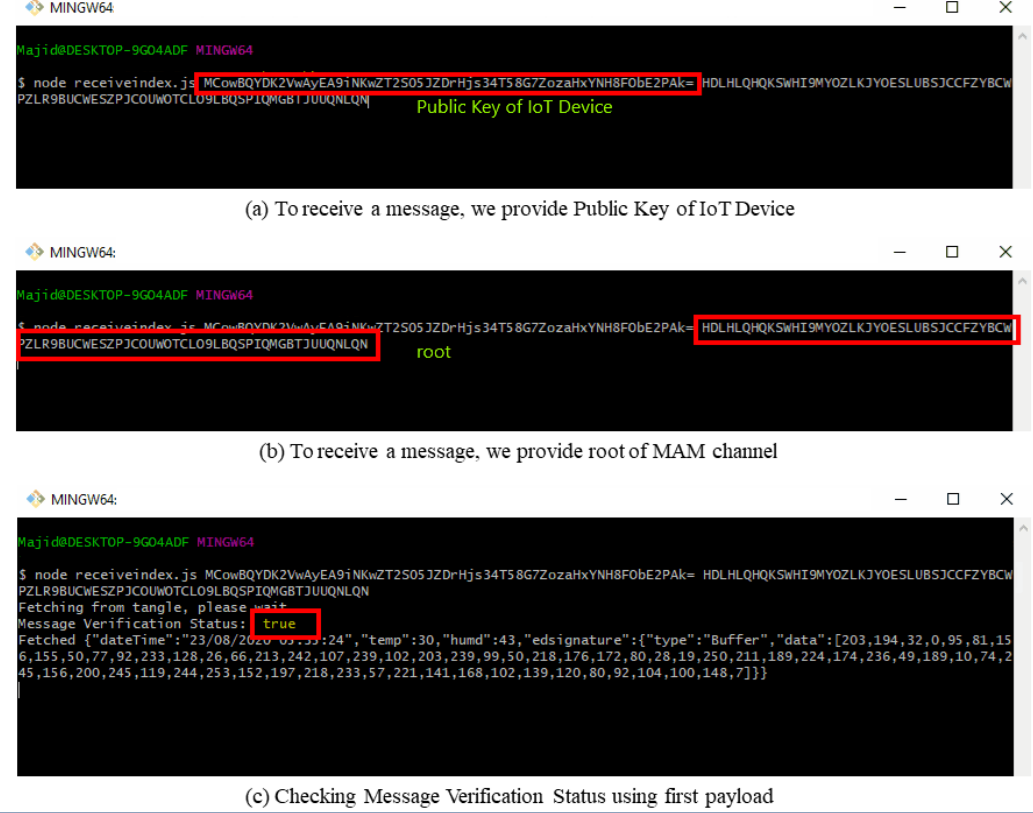
Figure 12. Fetching of the first message payload using a public key and root in ‘public’ mode .